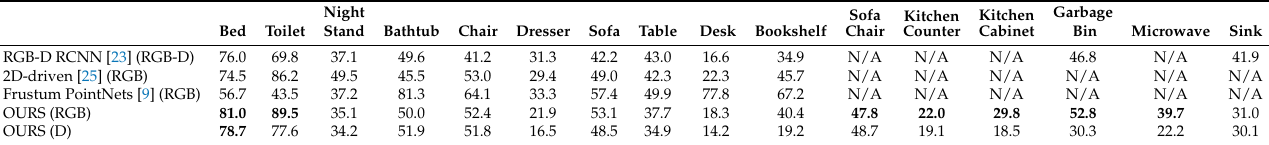
Table 3. 2D detection results based on SUN RGB-D validation set. Evaluation metric is average precision with 2D Intersection over Union (IoU) threshold of 0.5.